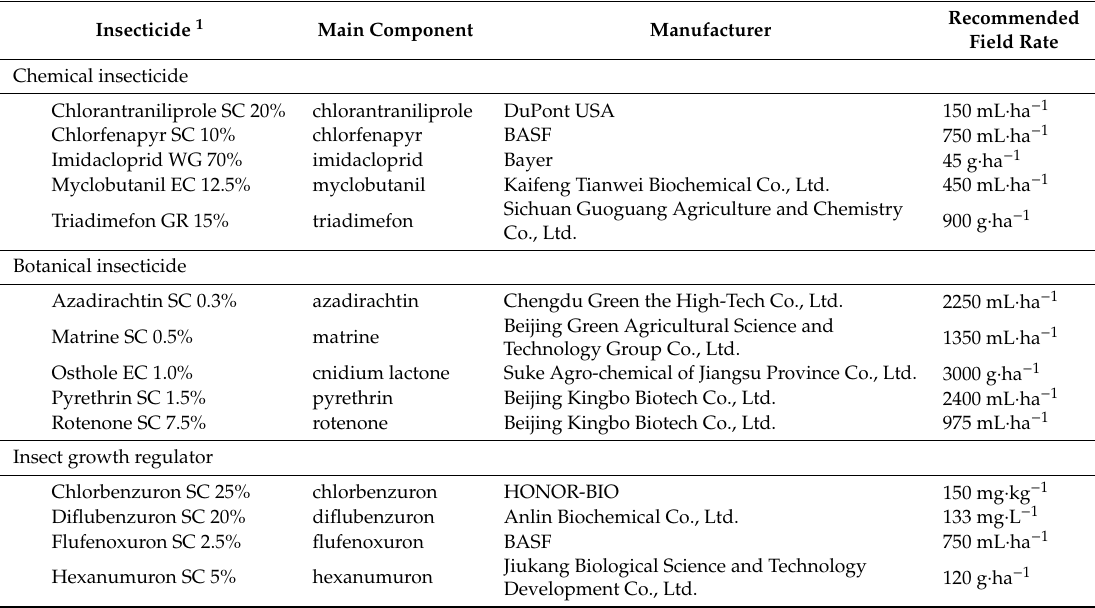
Table 1. Low-toxicity insecticides used in the